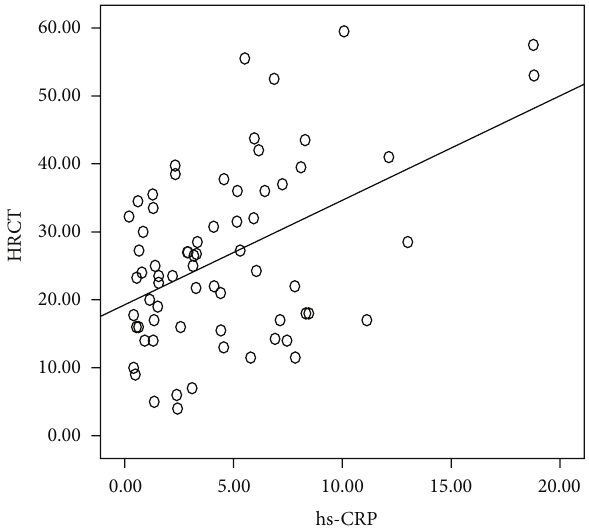
Figure 4: Relationship between serum high-sensitivity C-reactive protein (hs-CRP, mg/L) levels and HRCT scores in patients with stable bronchiectasis ( 𝑛 = 69 , 𝑟 = 0.473 , 𝑃 < 0.001 , by Pearson’s